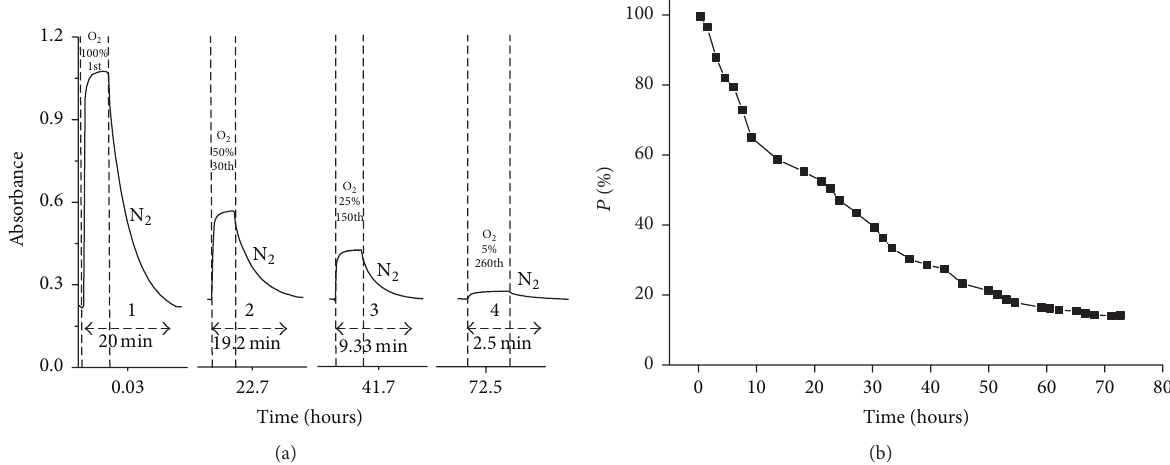
Figure 9: (a) Absorbance changed at 314 nm as N 2 and O 2 were bubbled alternately through an DABA-Co(II) complex aqueous solution ( 𝐶 Co ( II ) = 2.0 × 10 −4 mol ⋅ dm −3 ). (b) Percentage of oxygenation capacity (𝑃 % ) of DABA-Co(II) as a function of oxygenation time.